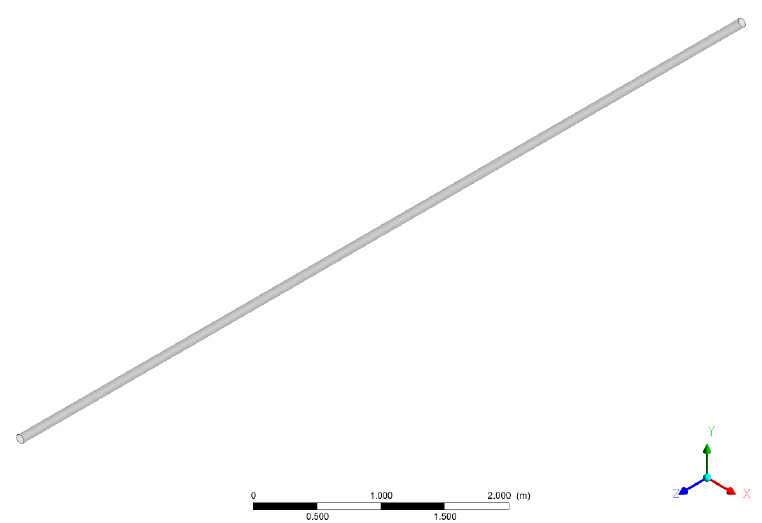
Figure 2. Geometry of the computational domain: the first version.